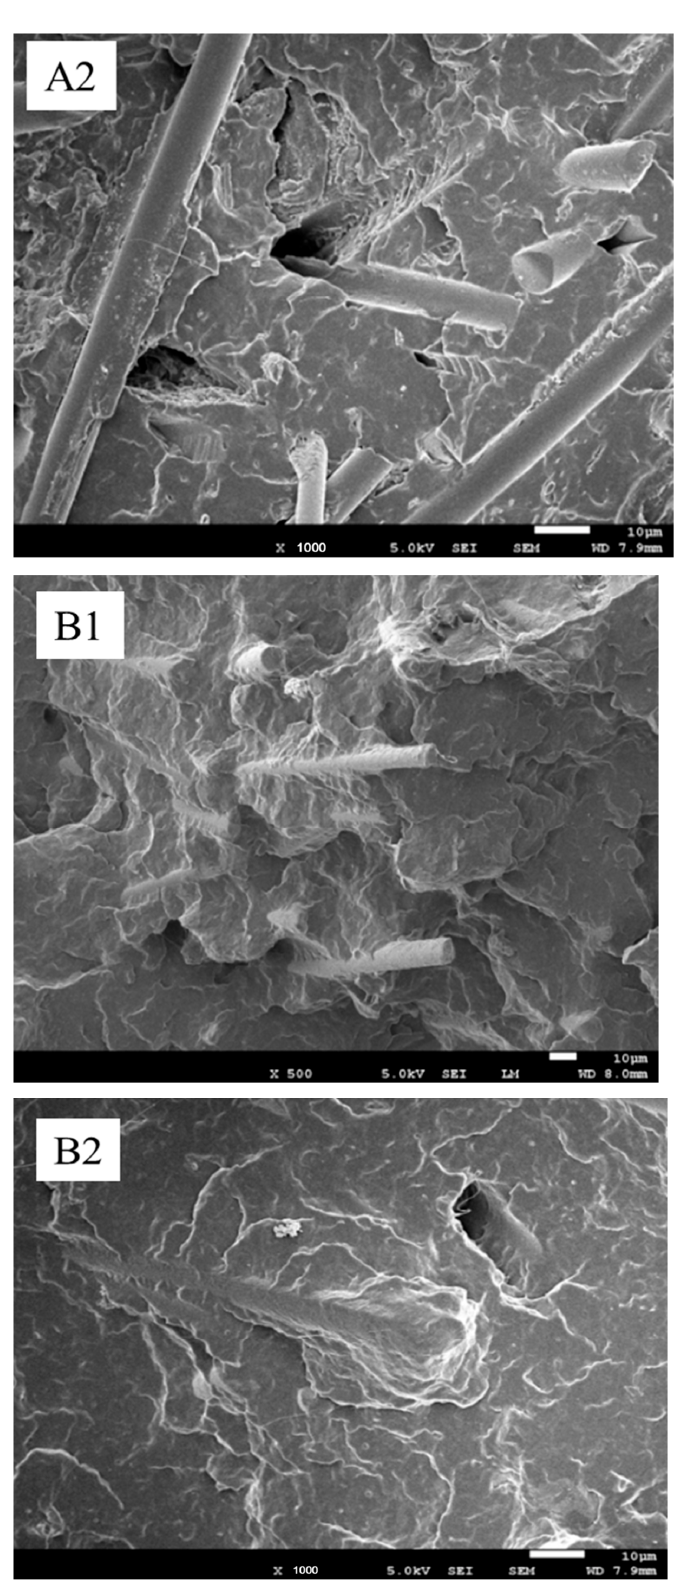
Figure 10. SEM images for fracture surface of impact specimen. ( A ) Before modification and ( B ) After modification.